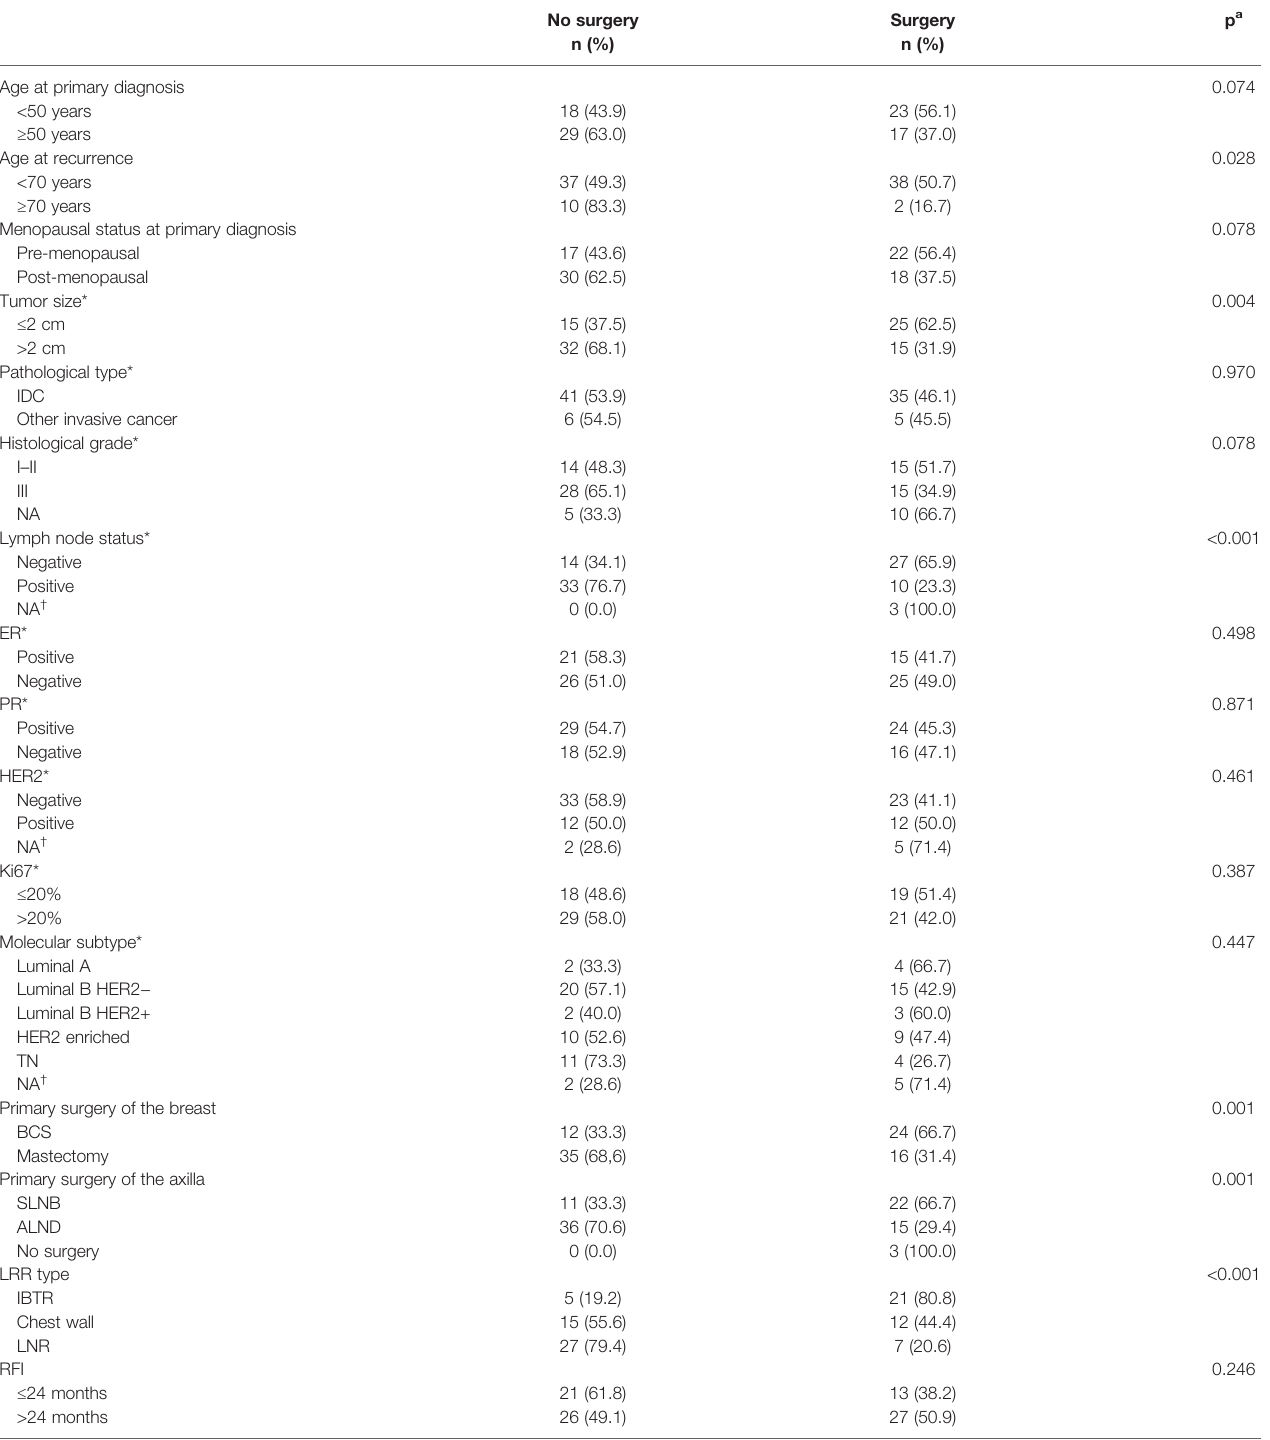
TABLE 3 | Univariate analysis for clinicopathological features related to salvage surgery decision for LRR patients. No surgery